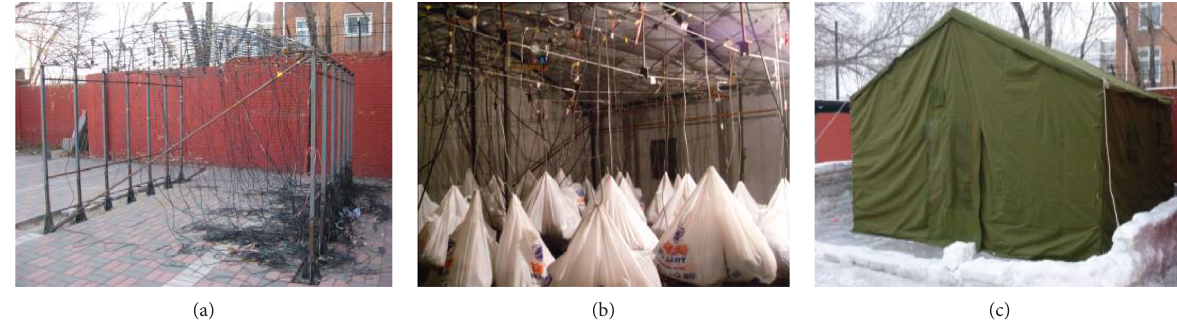
Figure 15: Experimental model of the CSBV structure. (a) CSBV test model. (b) Sandbags hanging on the test model. (c) Heat-retaining tent outside the CSBV model.